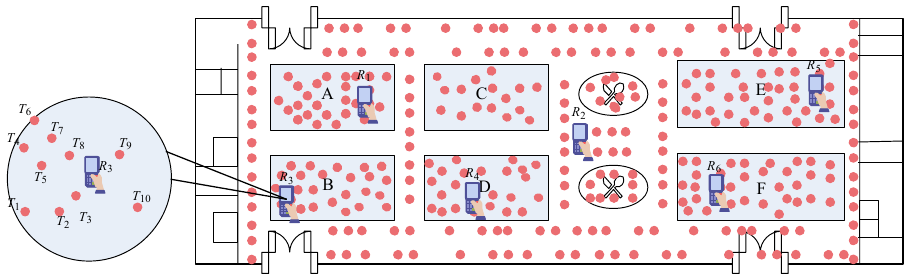
Figure 1. The plan of a large-scale indoor exhibition